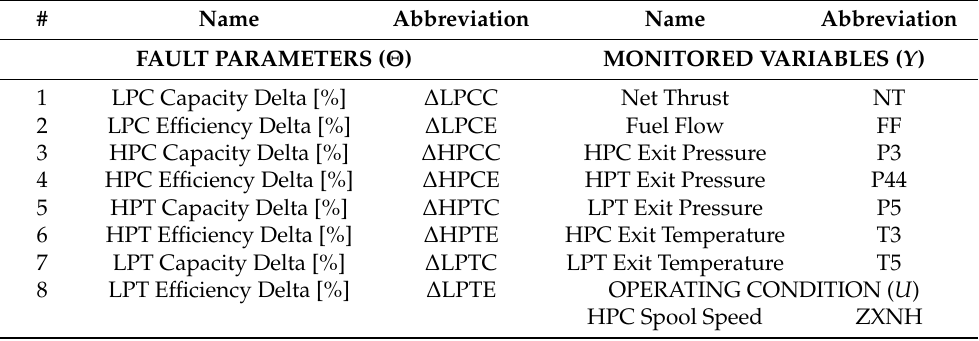
Table 8. Simulated quantities of turbo